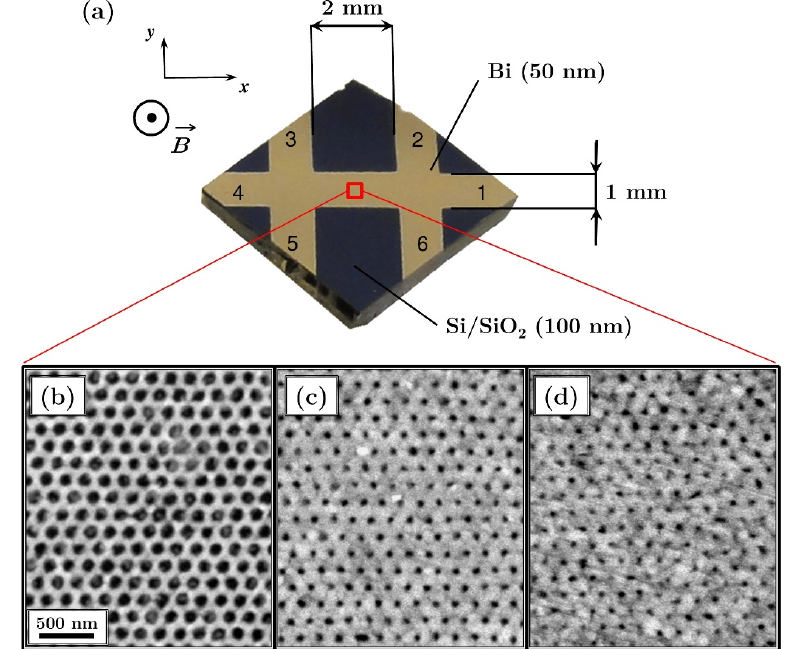
Figure 1. ( a ) Photograph of a sample showing dimensions and geometry of the double cross Hall bar. Below, scanning electron microscopy (SEM) image of a Bi antidot array with a period of 175 nm. The measured mean hole diameter is ( b ) 110 nm, ( c ) 65 nm, and ( d ) 45